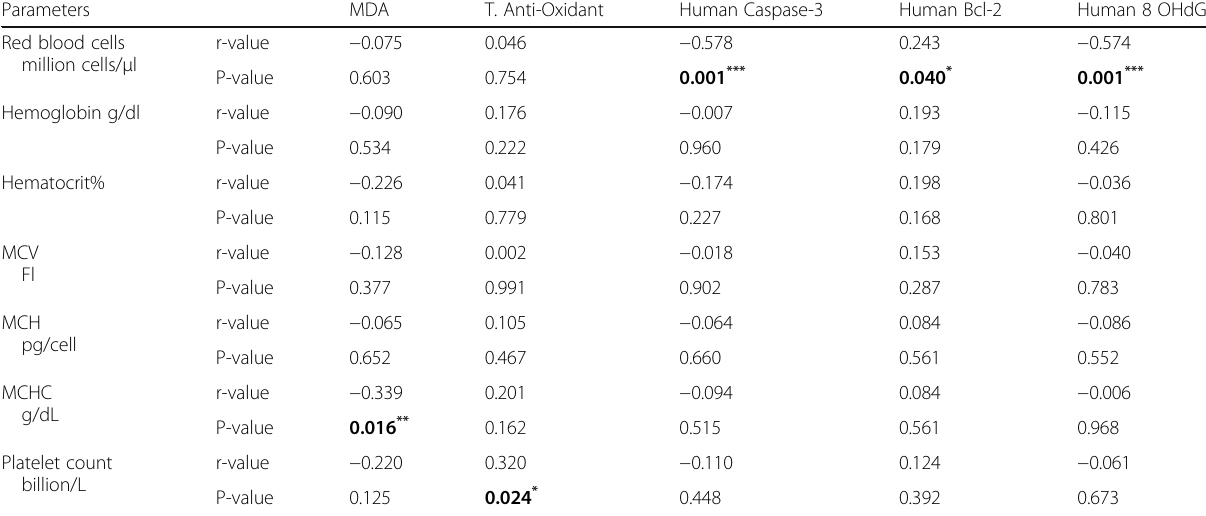
man 8-OHdG and showed a significant positive correl- ation with Bcl-2. MCHC showed significant negative correlation with MDA. The platelets showed significant positive correlation with total antioxidant.